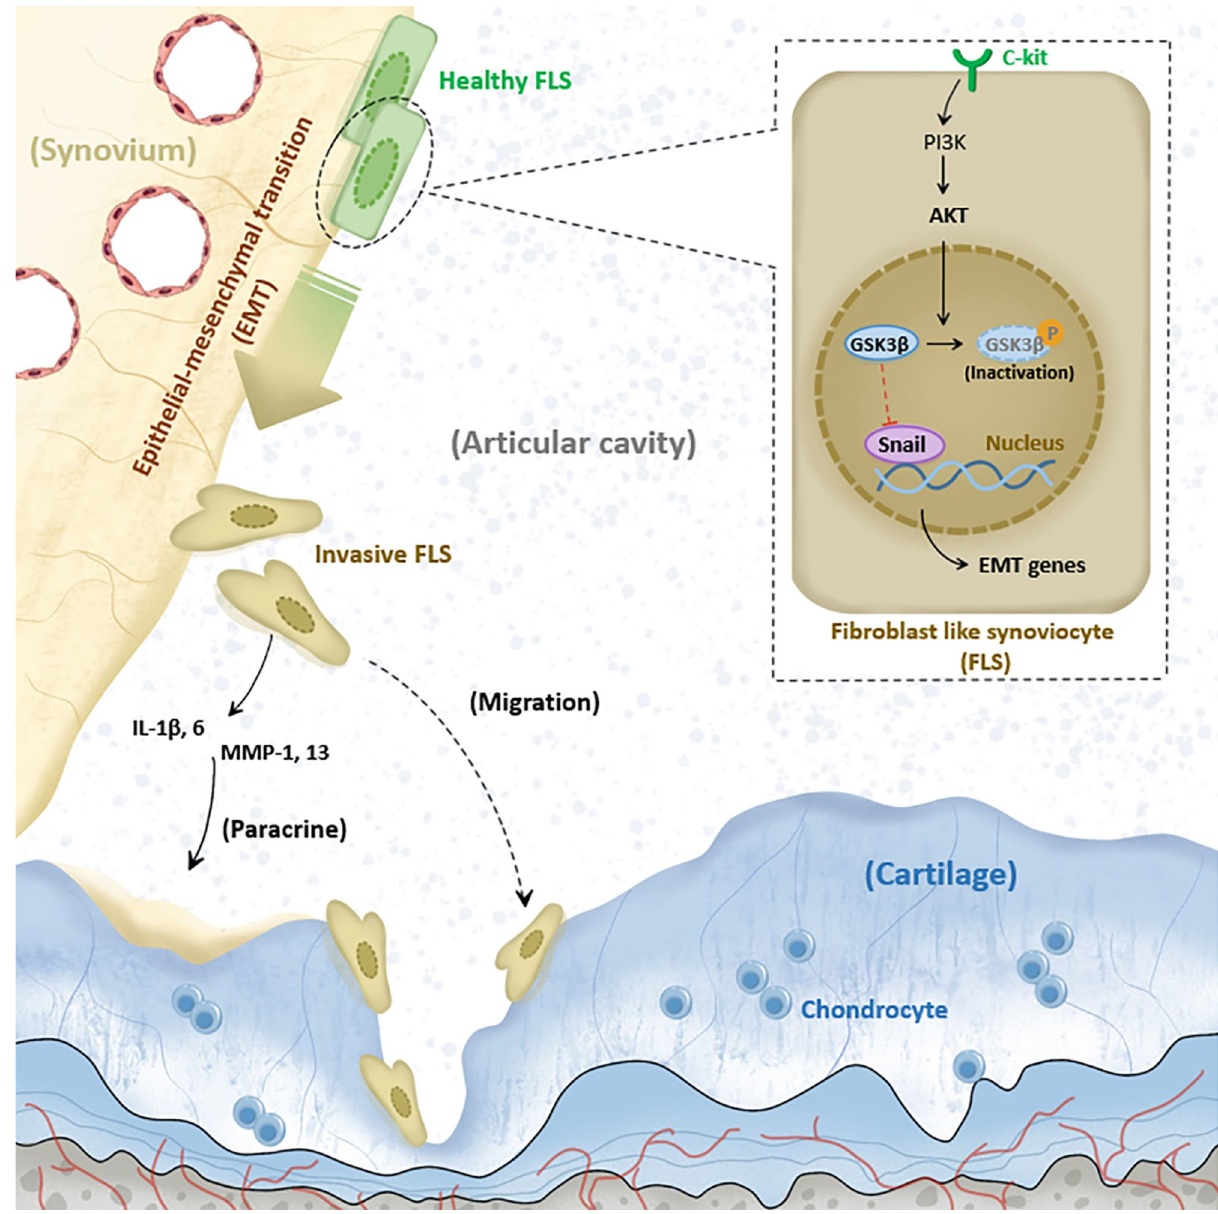
Fig. 3 C-kit increases in N-CDH + OA synovium (A) The top 20 upregulated (or downregulated) differential genes in the cluster based on their expression level of N- cadherin in 70 OA synovial samples. (B) Venn diagrams and heatmaps based on the intersection between the top 40 differential genes and EMT-related receptors involved in EMT. (C) The PPI network of N-cadherin- and C-kit- (A-B, red arrowhead) related DEGs between the N-CDH − or N-CDH + subclusters. Orange and blue circles represent genes with high and low expression in the N-CDH + subcluster, respectively. (D) C-kit expression in N-CDH − or N-CDH + OA synovium derived from different patients (n = 3). (E) The expression and location of C-kit (red) and N-cadherin (green) in two subpopulations of OA synovium by immunofluorescence (bar = 100 μm). N-CDH: N-cadherin; RTK: receptor tyrosine kinase; SMO: